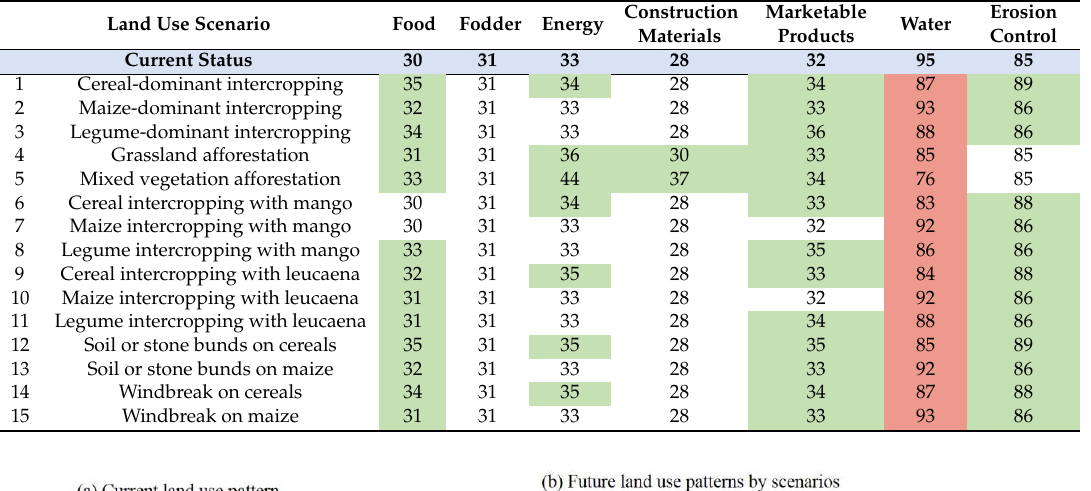
Table 6. The fifteen land use scenarios and their potential changes in ecosystem services provision for Bolgatanga. The increase from the current status is expressed by green color, whereas the decrease is indicated by red color. White means no change in the provision of ecosystem services compared to current land use.